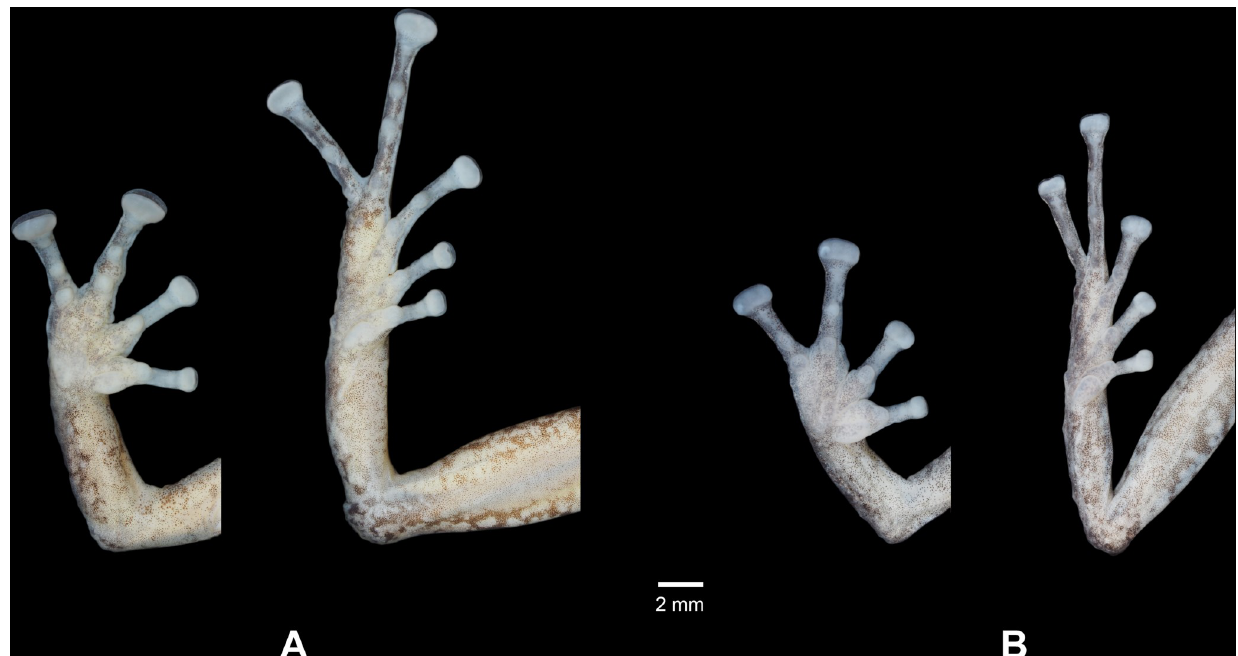
Fig 5. Palmar view of hand and plantar view of foot of (A) holotype of Pristimantis lojanus sp. nov. (MUTPL 178, adult female) and (B) paratype (MUTPL 1030, adult male) in preservative.